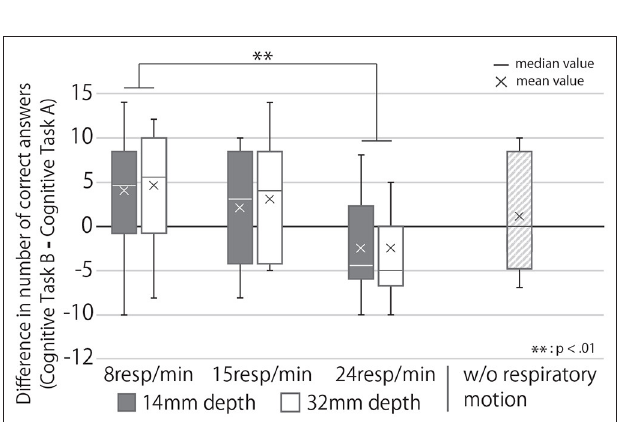
FIGURE 13 | Subjective mental workload score calculated by AWWL under each condition, normalized with “w/o respiratory motion condition.” If the value of the graph is greater than 1, it means that the subjective mental workload for the task was greater than when the subject had a device that did not present the respiratory